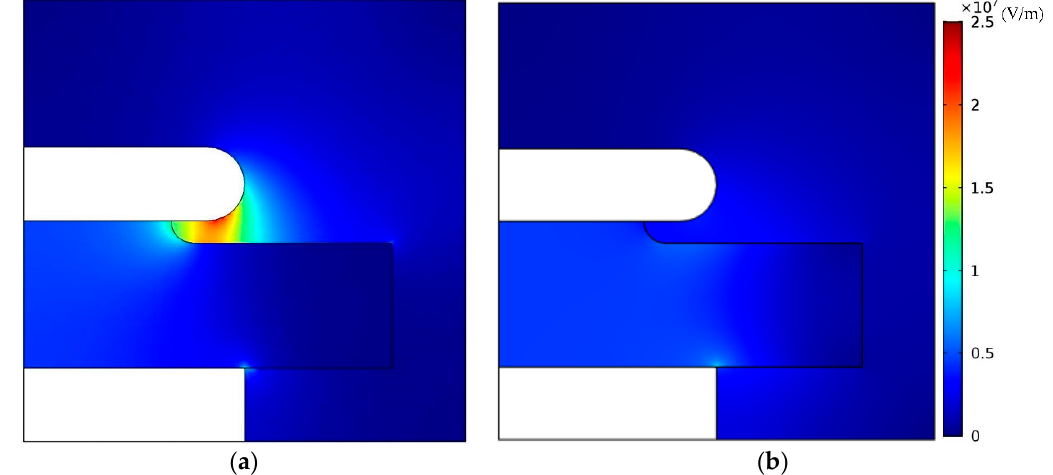
Figure 8. The electric field distribution of power modules for applying ( a ) neat epoxy material; and ( b ) non-linear conductivity epoxy/SiC composite.